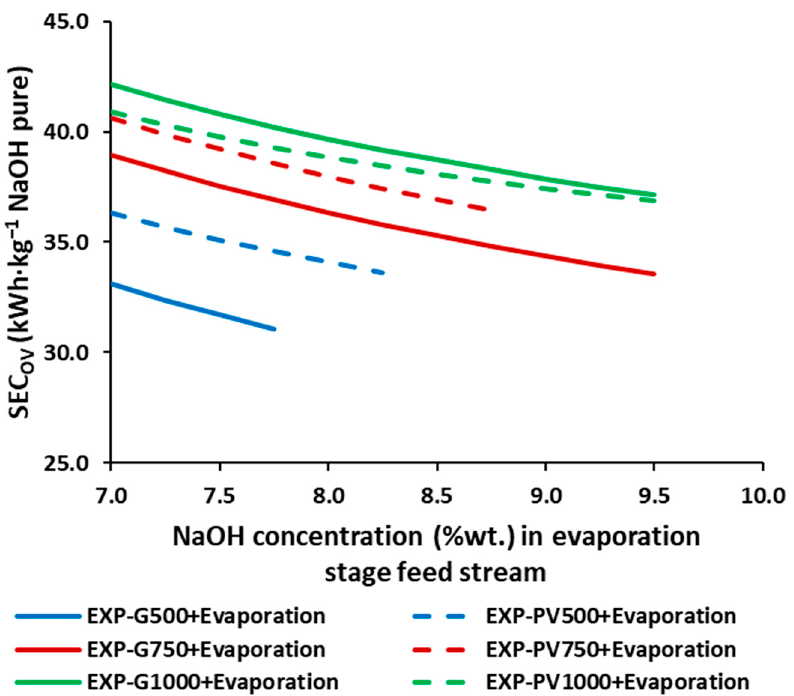
Figure 4. SEC OV for the different NaOH concentrations in the feed stream of the simulated triple effect evaporation for a target final concentration of 50%wt. effect evaporation for a target final concentration of 50%wt. NaOH.